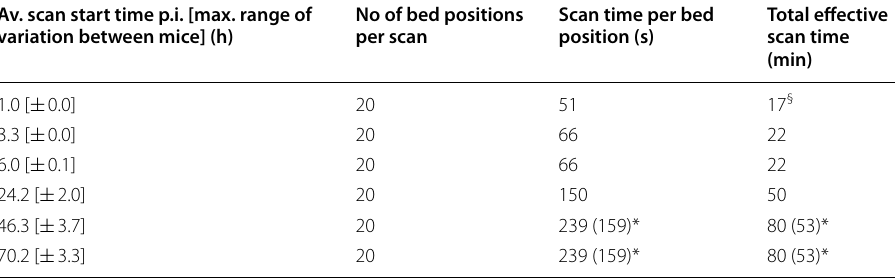
§ Scan duration limited by the start of the scans for the next time point *Because of a logistical limitation, this specification was used for the two mice from datasets LS1 and LS2